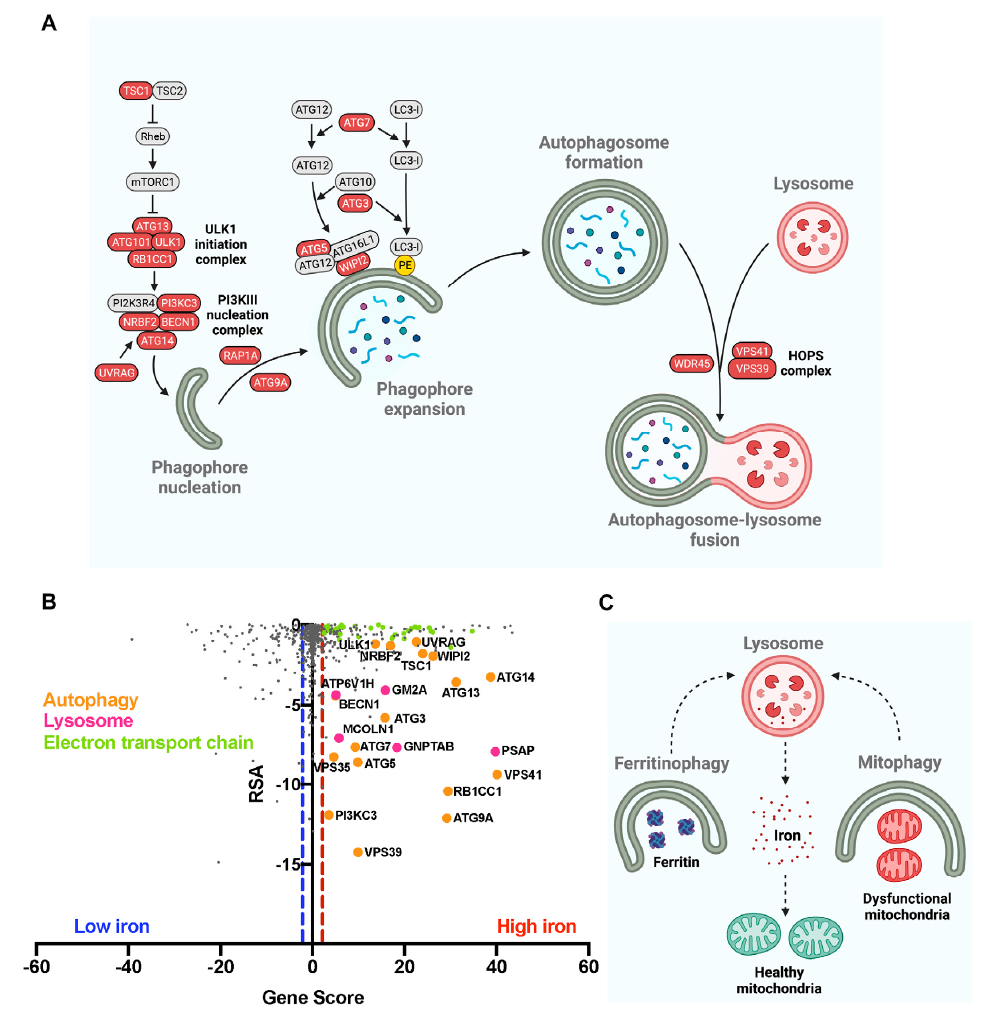
Figure 2. Autophagy impairment results in lysosomal iron overload in neurons. ( A ) CRISPRi downregulation of several genes participating in the macroautophagy process (colored in red) triggers lysosomal iron overload. ( B ) Correlation between phenotypic size effect on lysosomal iron levels (gene score) and NCOA4 abundance (RSA) from CRISPR-based screenings. Red and blue lines separate, respectively, the positive and negative hits from the non-hits of the lysosomal iron screening. ( C ) Two lysosomal degradative pathways, ferritinophagy and mitophagy, connect iron bioavailability with mitochondrial health maintenance.